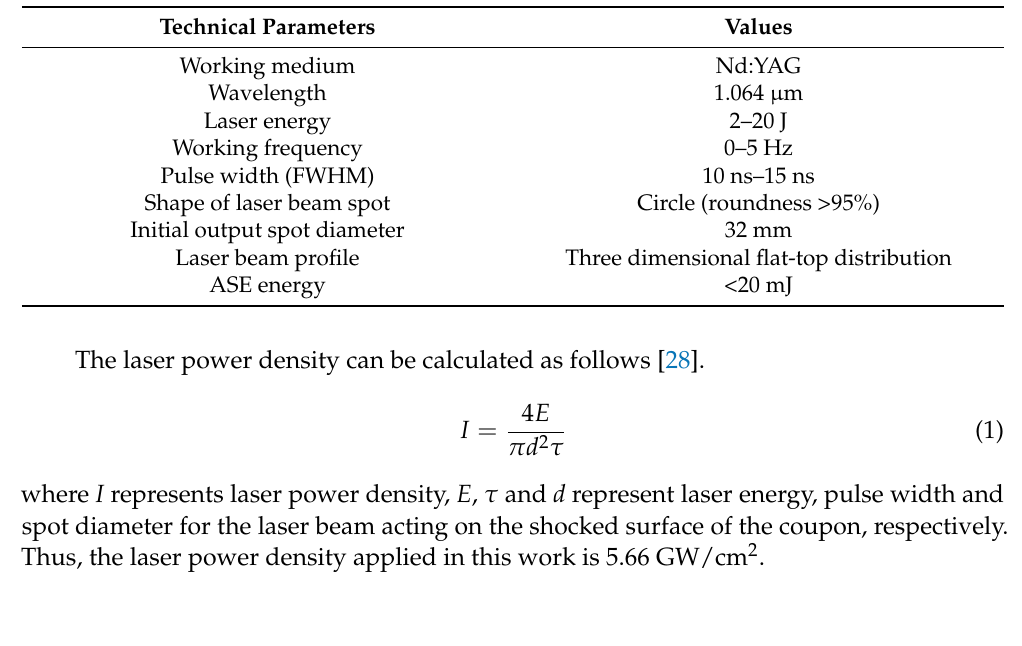
Table 2. Technical parameters for Q-switched Nd:YAG